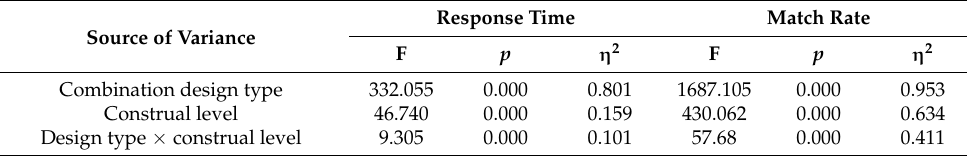
Table 4. ANOVA results for combination design type and construal level.